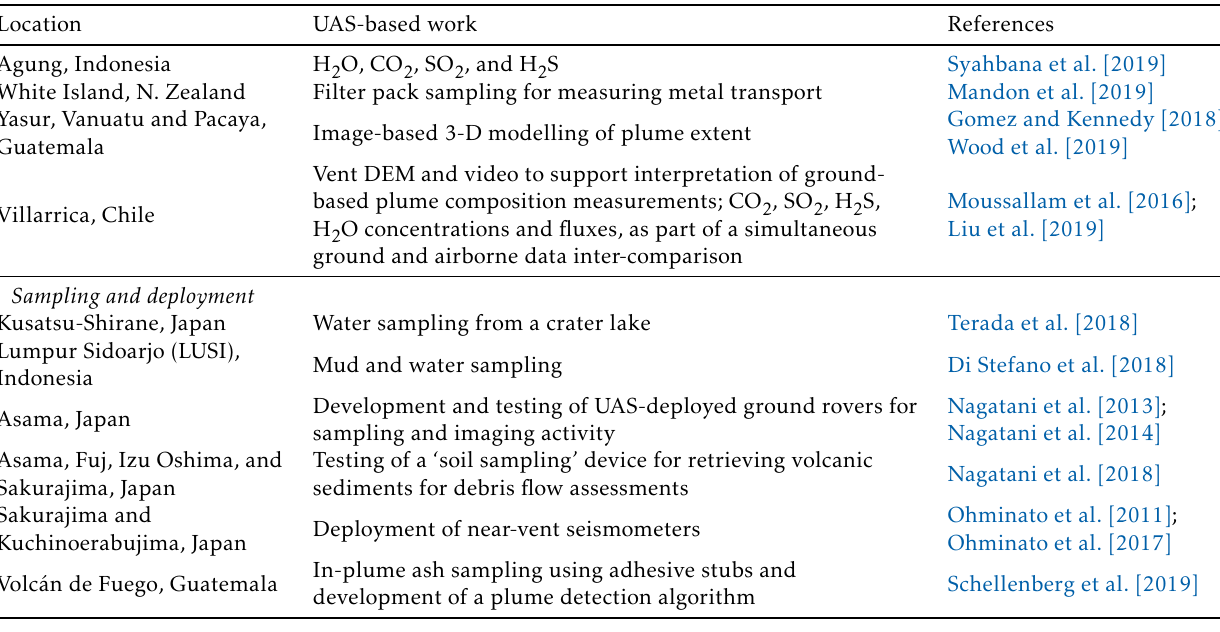
Table 1: [cont.] – Example UAS applications in